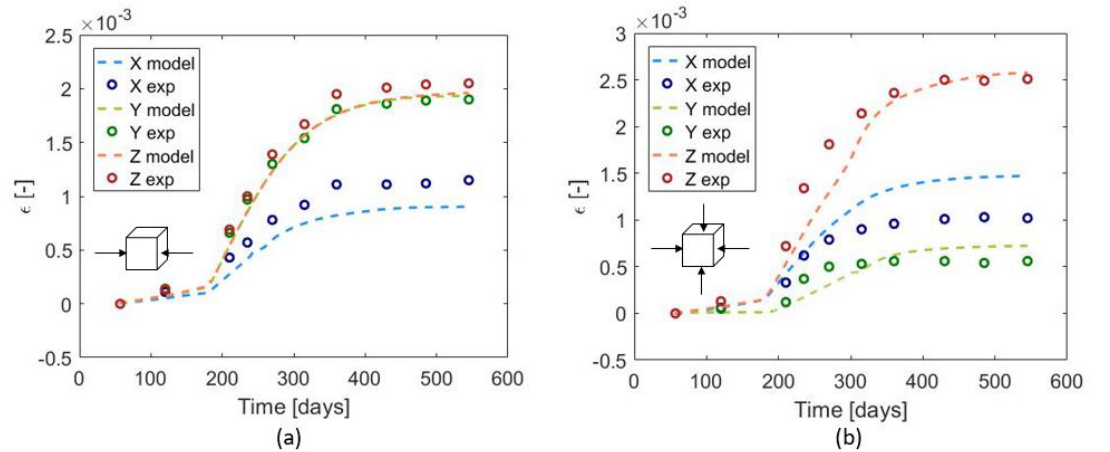
Figure 4. Comparison between experimental data of Gautam’s campaign and model results obtained through 3D FE analysis, in terms of X, Y, and Z strains: ( a ) Uniaxial compression with σ x = − 3.9 MPa, and ( b ) biaxial case with σ x = σ y = − 3.9 MPa.